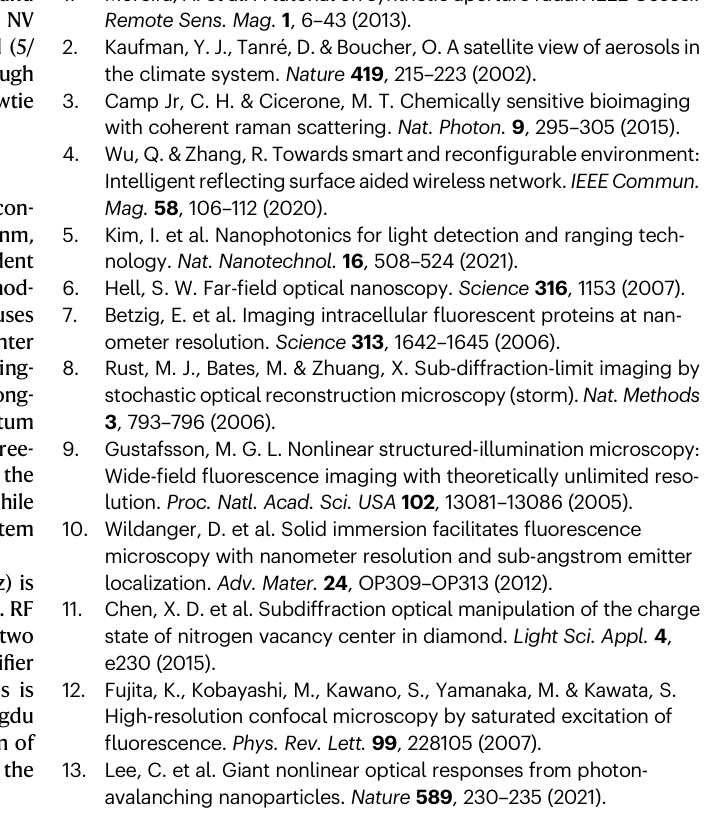
Fig.5|Theschematicdiagramofexperimentalsetupfortheradiorangingwith NVcenter. DM,long-passdichroicmirrorwithanedgewavelengthof552nm;AOM acousto-opticmodulator,SPCMsingle-photon-countingmodulator,PBSpolarizing